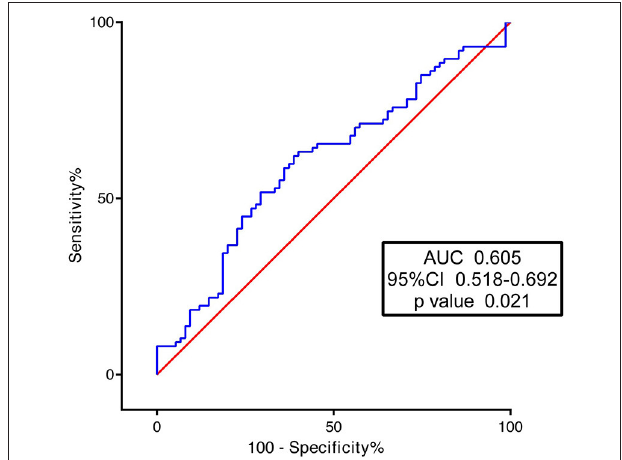
FIGURE 6 | Receiver operating characteristic curves of hyaluronan (HA) for predicting plaque